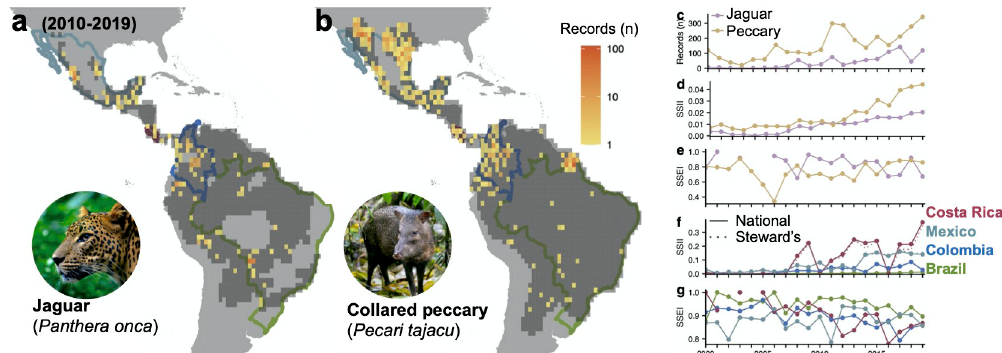
Fig 2. Species and national example patterns and trends. SSII and SSEI trends illustrated for 2 species, the jaguar ( Panthera onca ) and collared peccary ( Pecari tajacu ). ( a, b) The expected occupied cells are shown in dark gray, and total number of records collected 2010–2019 in color. ( c–e) Species-level time series of the total number of records ( c ), Global SSII for the whole species range (i.e., all countries with expected range) ( d ), and Global SSEI ( e ) across their expected range. ( f, g) Resulting National and Steward’s SSII ( f ) and SSEI ( g ) for 4 countries. Photographs from Wikimedia (see Text A in S1 File). National boundaries from gadm . org. Numerical values available in Tables A and B in S1 File. The data underlying this figure may be found in https://mol.org/indicators/coverage and https : //github . com/MapofLife/biodiversity-data-gaps . SSEI, Species Sampling Effectiveness Index; SSII, Species Status Information